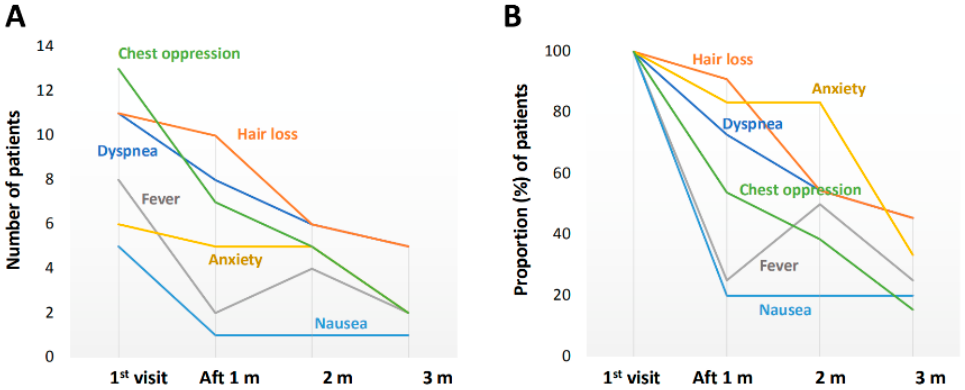
Figure 3. Improvements in other symptoms of long COVID during the three-month follow-up pe- riod. Changes in ( A ) the number of patients and ( B ) the proportion (%) of patients with each symp- tom.